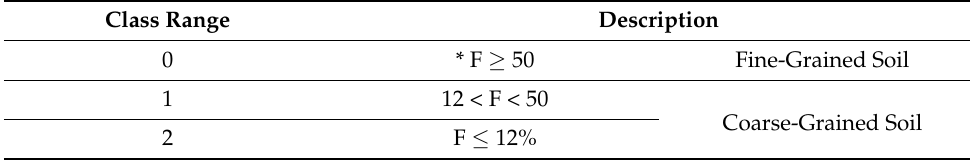
Table 8. Criteria for classification in step 1.